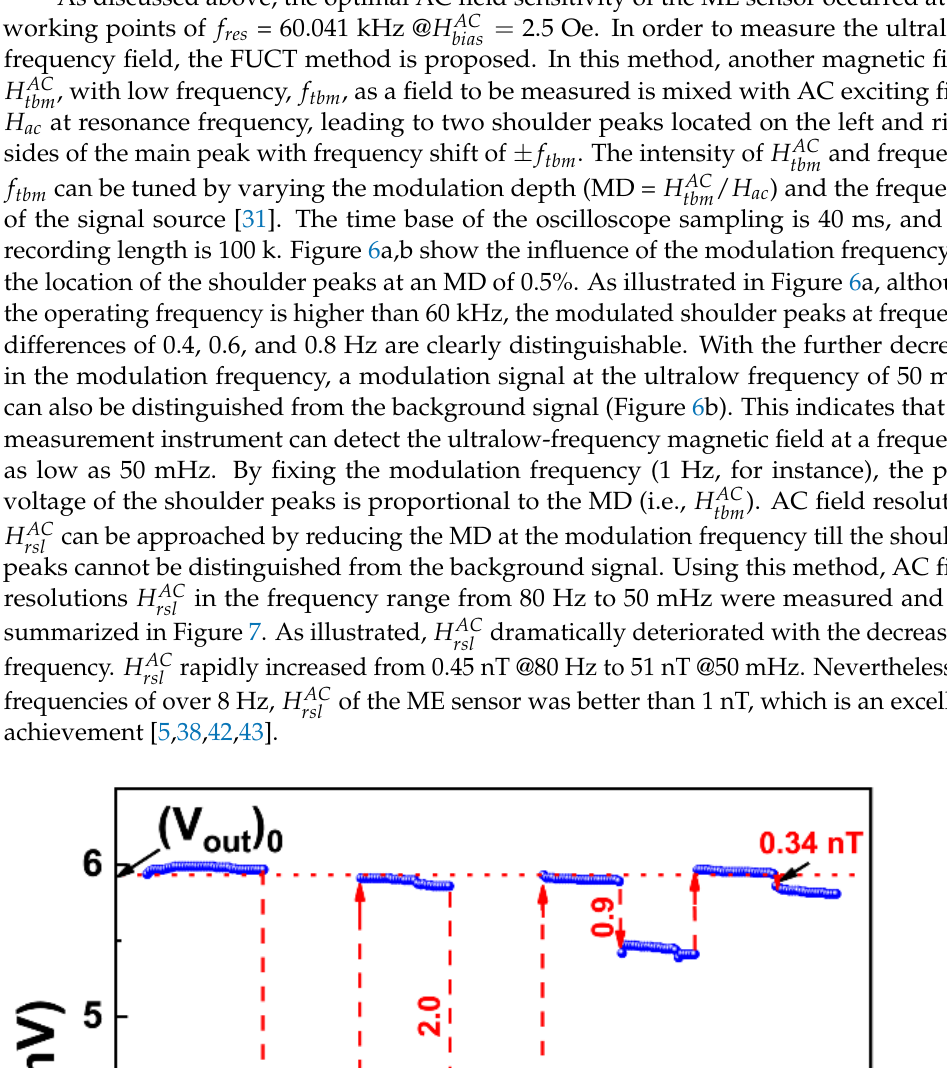
at f res = 60.101 kHz and H DC rsl